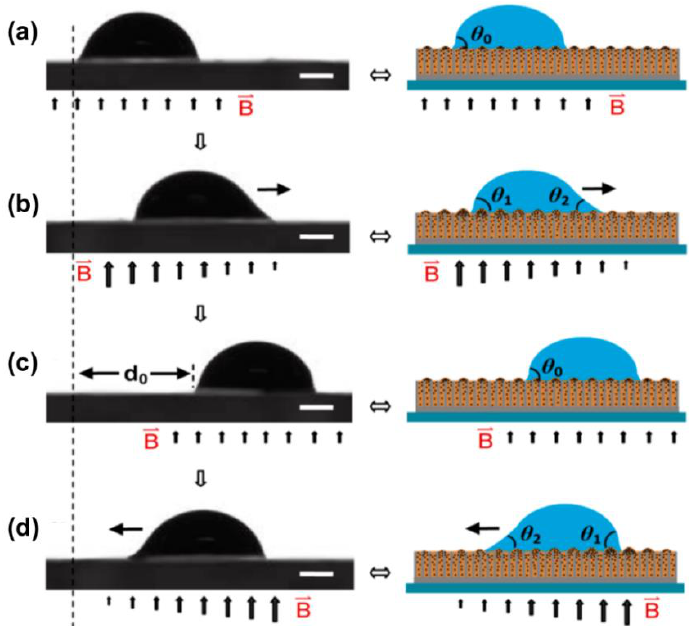
Figure 13. ( a ) Images of droplets moving towards a hydrophilic filter, away from the tilted microcilia. ( b ) Scheme of a water flow distributor, consisting of an inspirator underlying the LIS and 8 hydrophilic channels. ( c ) Illustration of controlling droplet sliding direction Water dyed with different colors was delivered through a plastic pipe and contacted the surface’s ferromagnetic microcilia surface. By varying the direction of the magnetic field, the tilting direction of the microcilia is changed, which switches the water flow in a defined direction. Reproduced with permission [68]. Copyright 2017, Wiley-VCH.